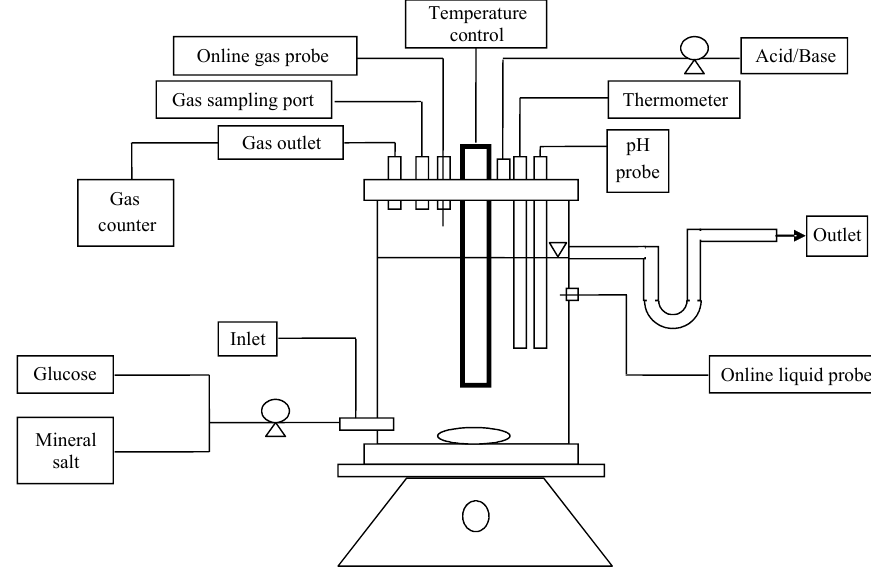
Figure 1. Schematic diagram of reactor set-up.